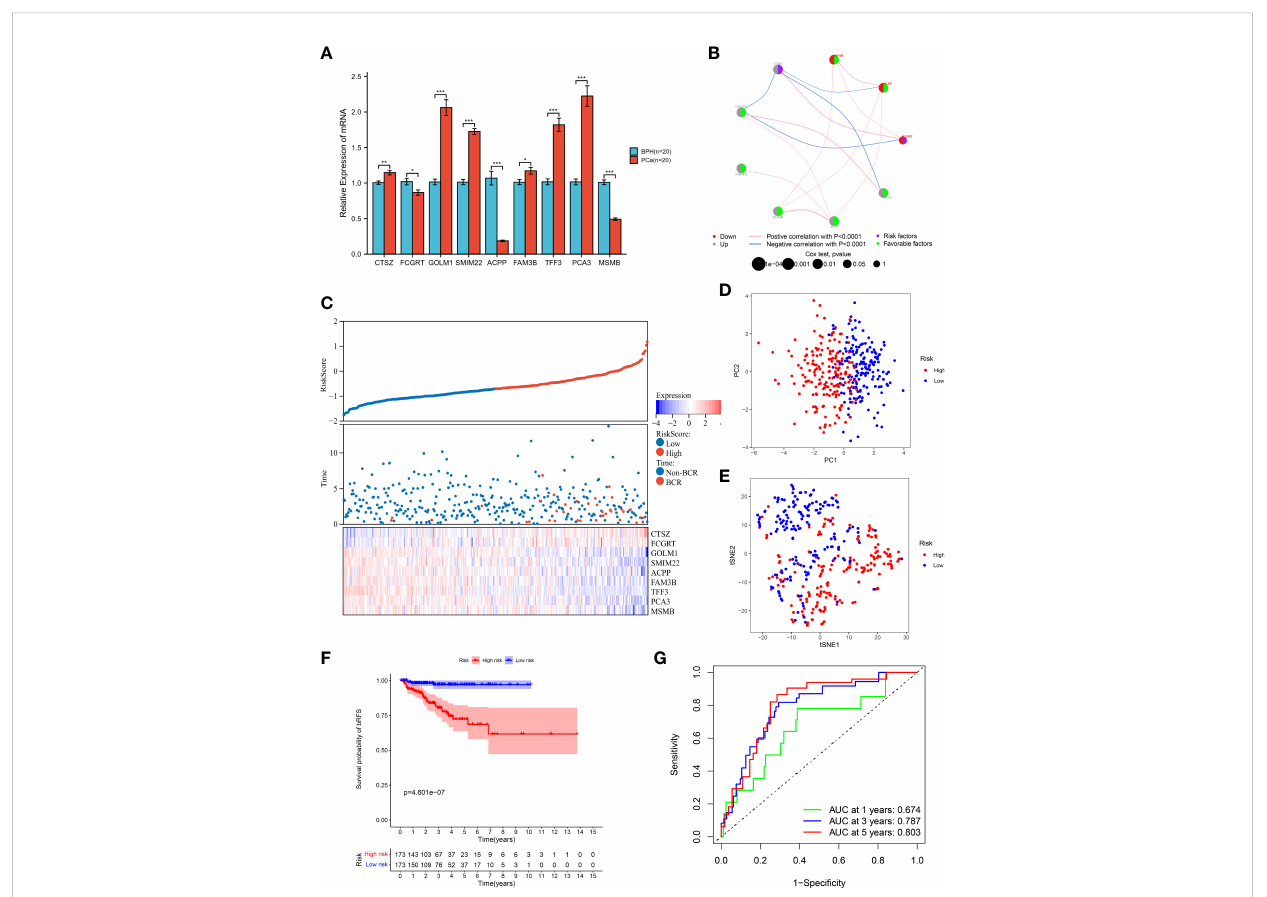
FIGURE 4 Prognostic value of MRMGPS in TCGA cohort. (A) The mRNA levels of MRMGPS-based genes in 20 fresh PCa and 20 BPH tissue samples detected by RT- qPCR. (B) Interaction between signature genes in PCa. The lines connecting the genes represent their interactions with the thickness representing the strength of the association and the color representing blue-negative or pink-positive associations. The color of the left dots represents the grey-upregulation or red-downregulation of the genes and the color of the right dots represents the purple-risk factors or green-favorable factors of the genes. The size of dots represents the effect of each gene on the prognosis. (C) Relationship between risk score and follow-up time, BCR events, and changes of model genes expression in PCa patients. (D) PCA plot displaying the distribution of high- and low-risk groups. (E) t-SNE plot displaying the distribution of high- and low- risk groups. (F) Kaplan – Meier curves for the probability of bRFS grouped in high- and low-risk groups. (G) ROC curves for the predictive ef fi ciency in 1-, 3-, and 5-year bRFS of MRMGPS. BPH, benign prostatic hyperplasia; ROC, receiver operating characteristic; AUC, area under the ROC curve; BCR, biochemical recurrence. * P < 0.05, ** P < 0.01, *** P <